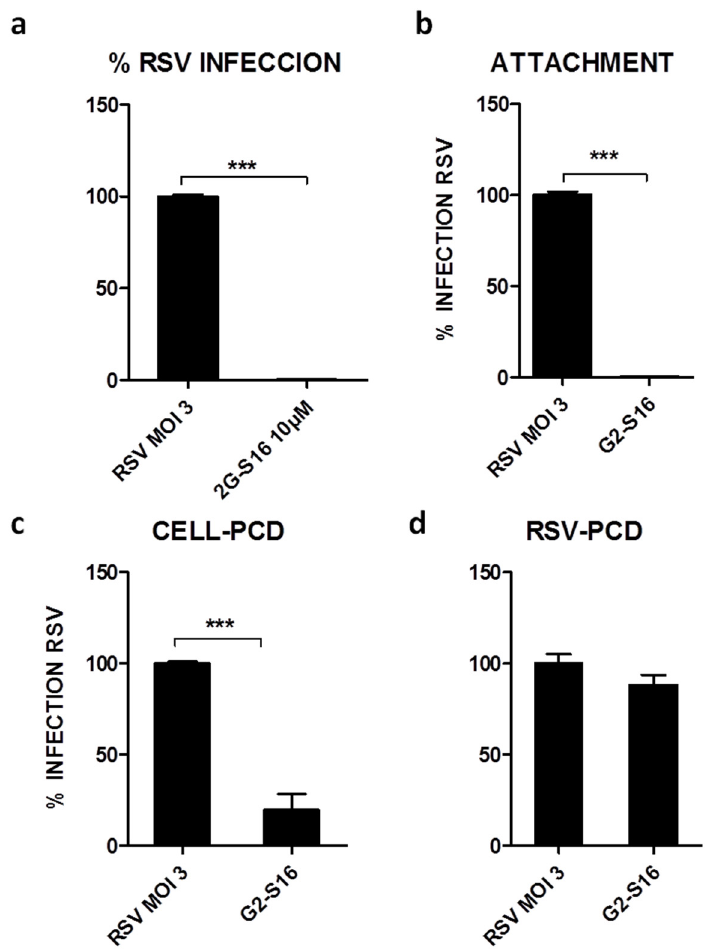
Figure 2. Mode of action of G2-S16 dendrimer against RSV infection. ( a ) Cells were infected 24 h, and culture supernatants were titrated in HEp-2 cells. ( b ) The effect of G2-S16 dendrimer on RSV binding. A549 cells were pre-chilled at 4 °C for 30 min and then treated and infected with RSV for 1 h at 4 °C. ( c ) Binding of G2-S16 dendrimer to cellular surface proteins. A549 cells were pre-treated 1 h with G2-S16 dendrimer. After incubation, A549 cells were washed to eliminate unbound G2-S16 dendrimer and infected with RSV. ( d ) Percentages of at one MOI 3 of RSV. The G2-S16 dendrimer was preincubated with RSV for 1 h at 4 °C. HEp-2 cells were infected 1 h at 3 MOI at 4 °C. The graph represents the relative mean of three independent experiments. G2-S16 dendrimer infection was made at a MOI 3. Infection control: non-treated infected A549 cells at 3 MOI. Data were represented as mean ± standard deviation of three independent experiments. Error bars corresponding to the SD inter-experiment ( n = 3), *** p < 0.001.